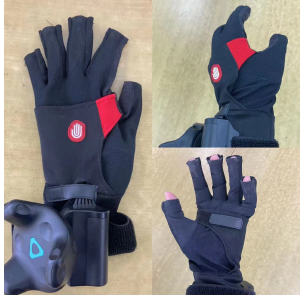
Figure 1. VR data